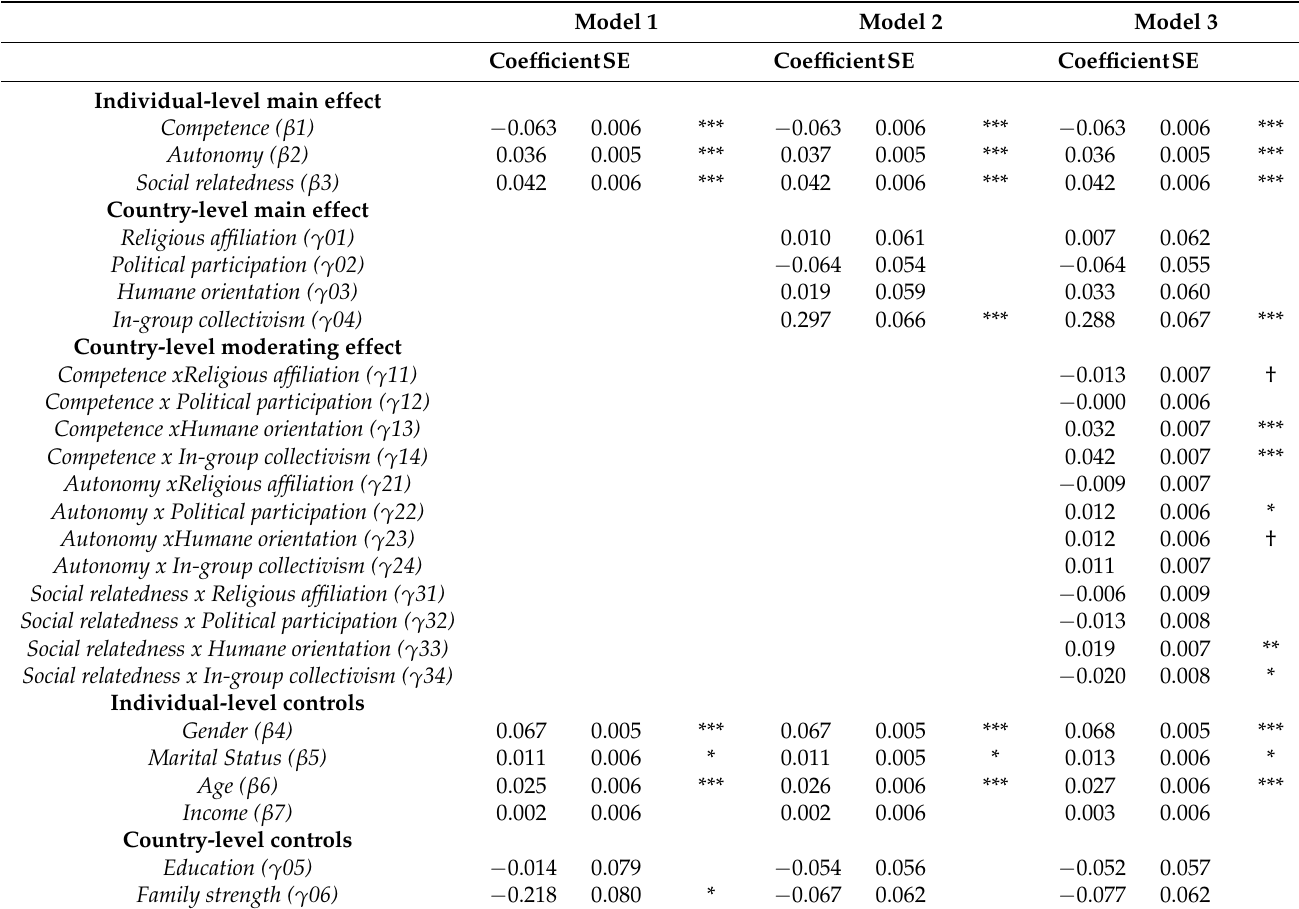
Table 5. HLM results: (The DV is work motivation) a,b